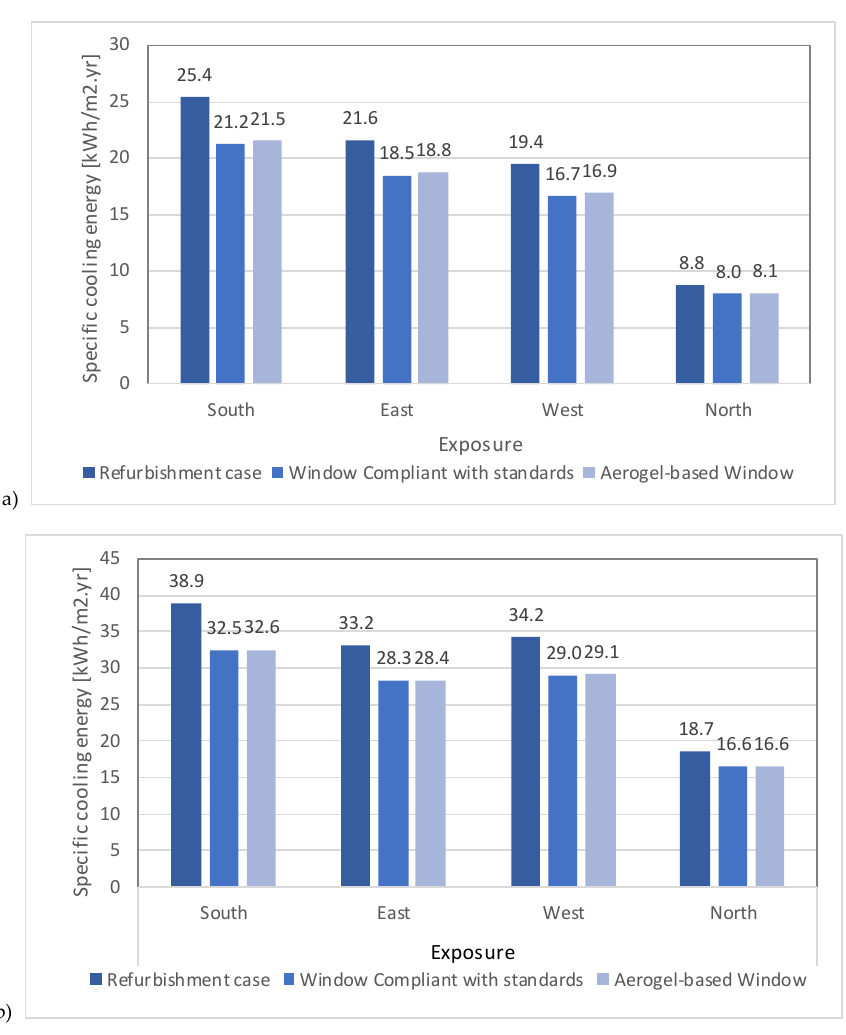
Figure 7. Cooling energy consumptions (kWh / m 2 · yr) in Toronto ( a ) and in Bari ( b ), according to exposures and window type. 299